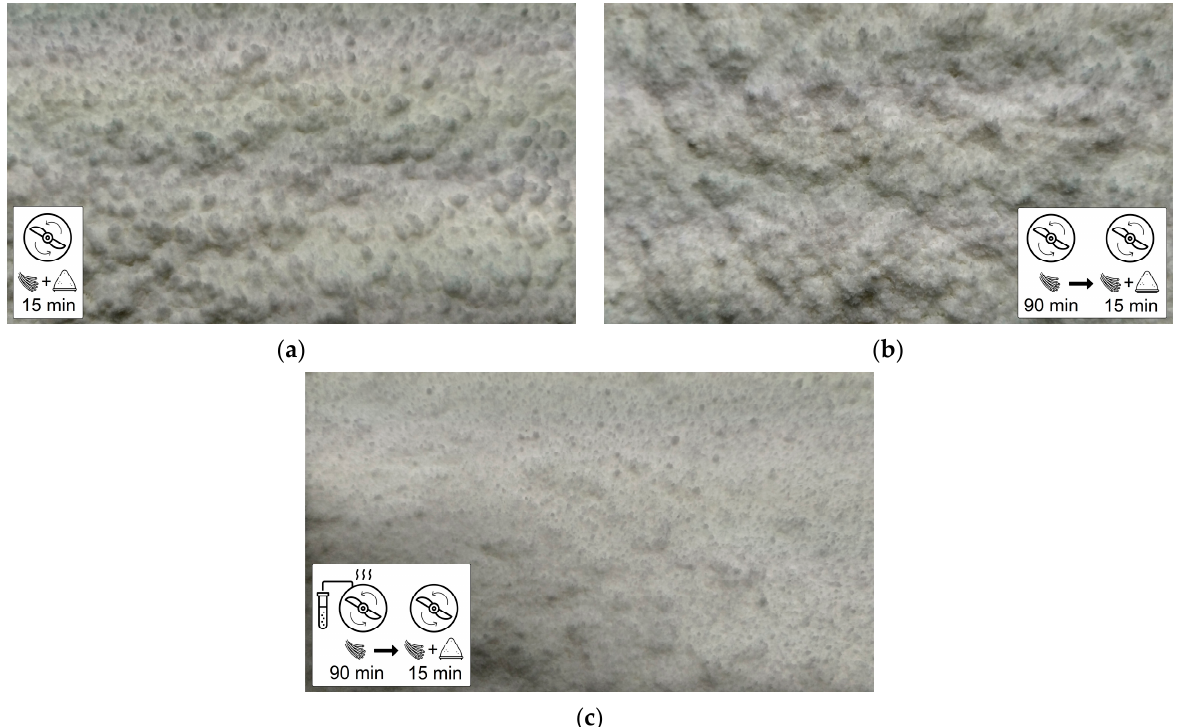
Figure 8. Photographs of the mixtures of polypropylene with three different cellulose samples after the mixing process, where bundles of cellulose fibers are highlighted using High dynamic range (HDR) technology: ( a ) PP mixture with untreated cellulose; ( b ) PP mixture with untreated cellulose mechanically premixed in the blender without plasma treatment for 90 min; ( c ) PP mixture with functionalized cellulose.